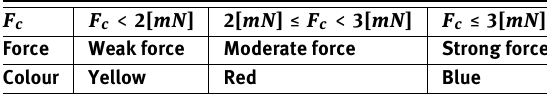
Table 5. An example of the relationships between force F c and colour changing